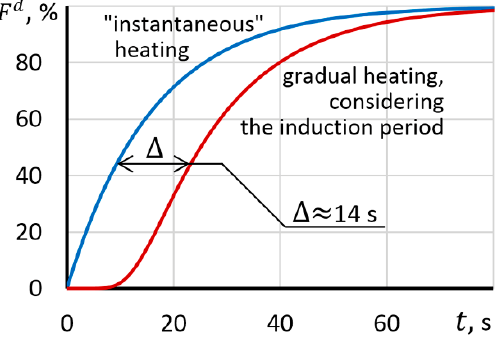
Figure 7. The percent change of spore death vs time plot under instantaneous and gradual